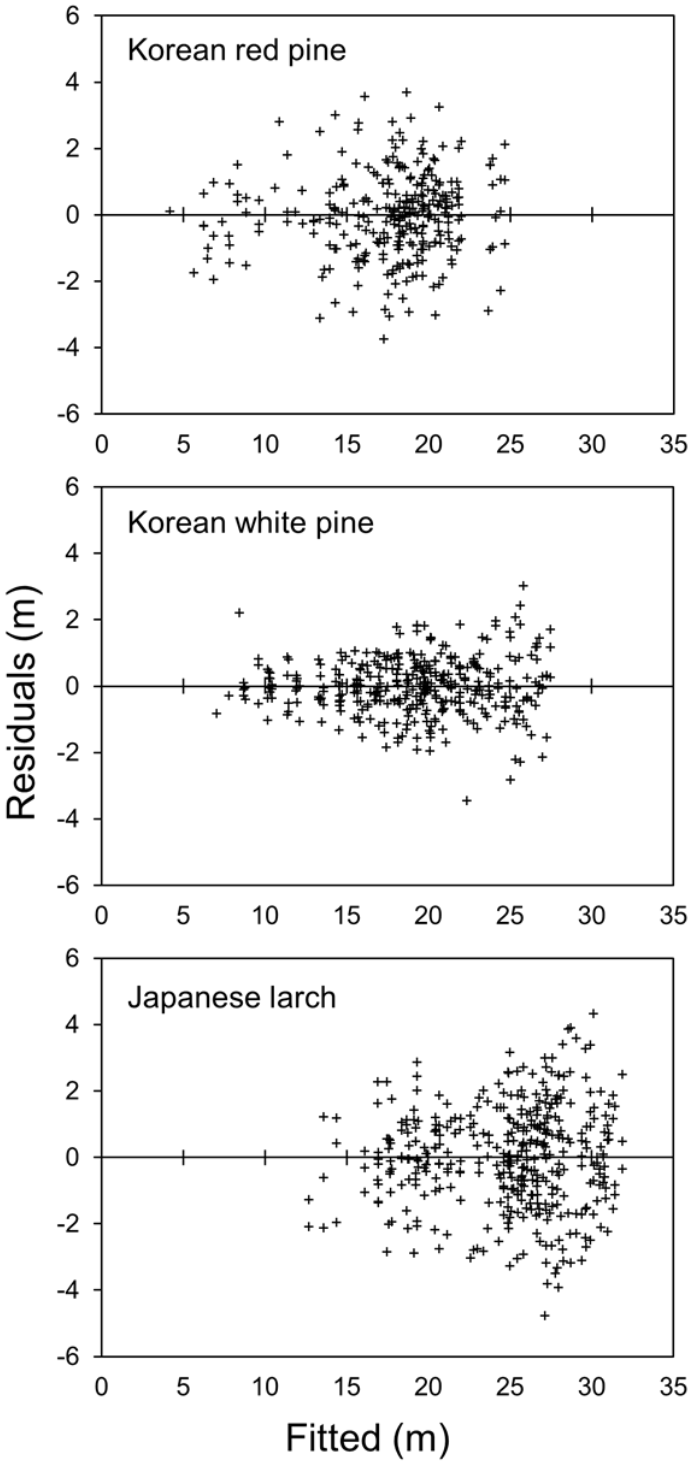
Figure 1. Residual plots for the dominant height model over the fitted values based on the Chapman – Richards function by species. The fitted values were derived from the mixed-effect parameters in Table 3 using Equation (10).